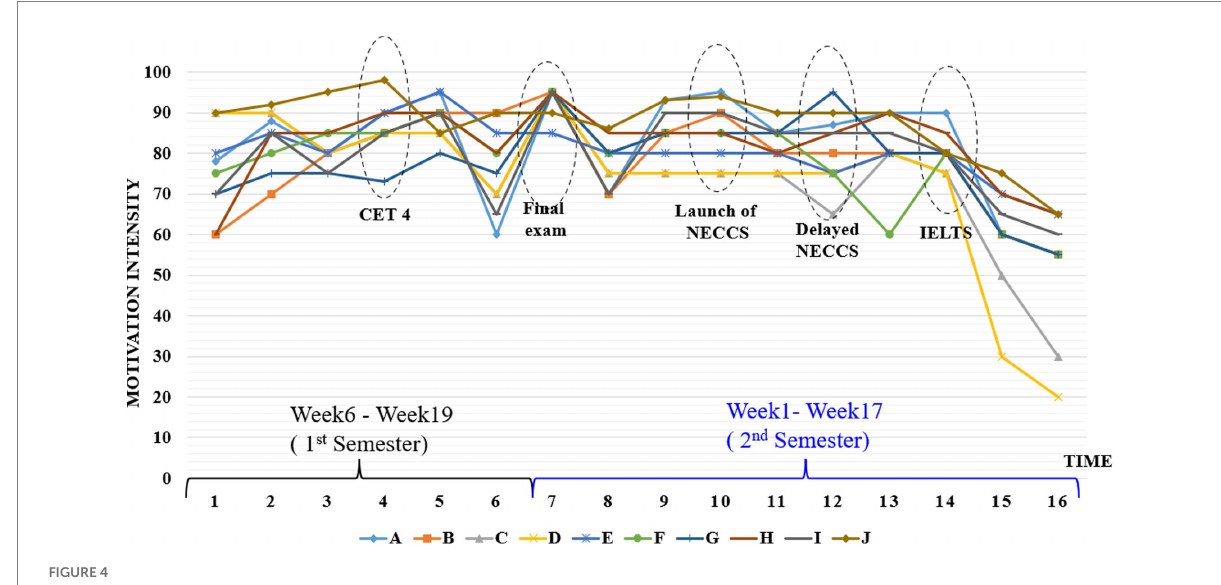
FIGURE 4 Relationship between exams and motivational